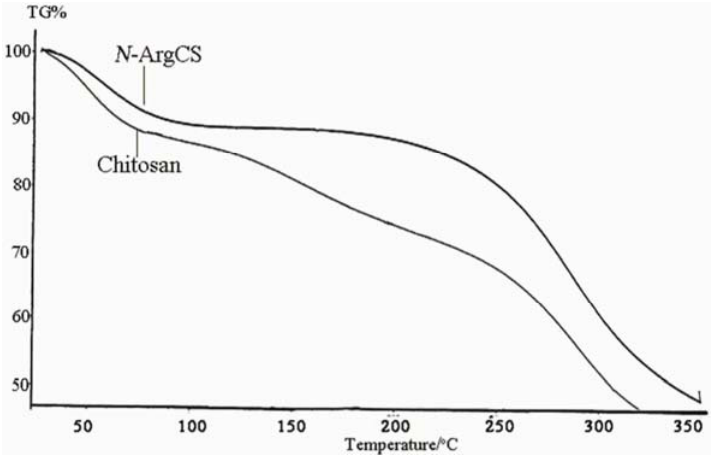
Figure 2. TG thermogravimetric of CS and N-